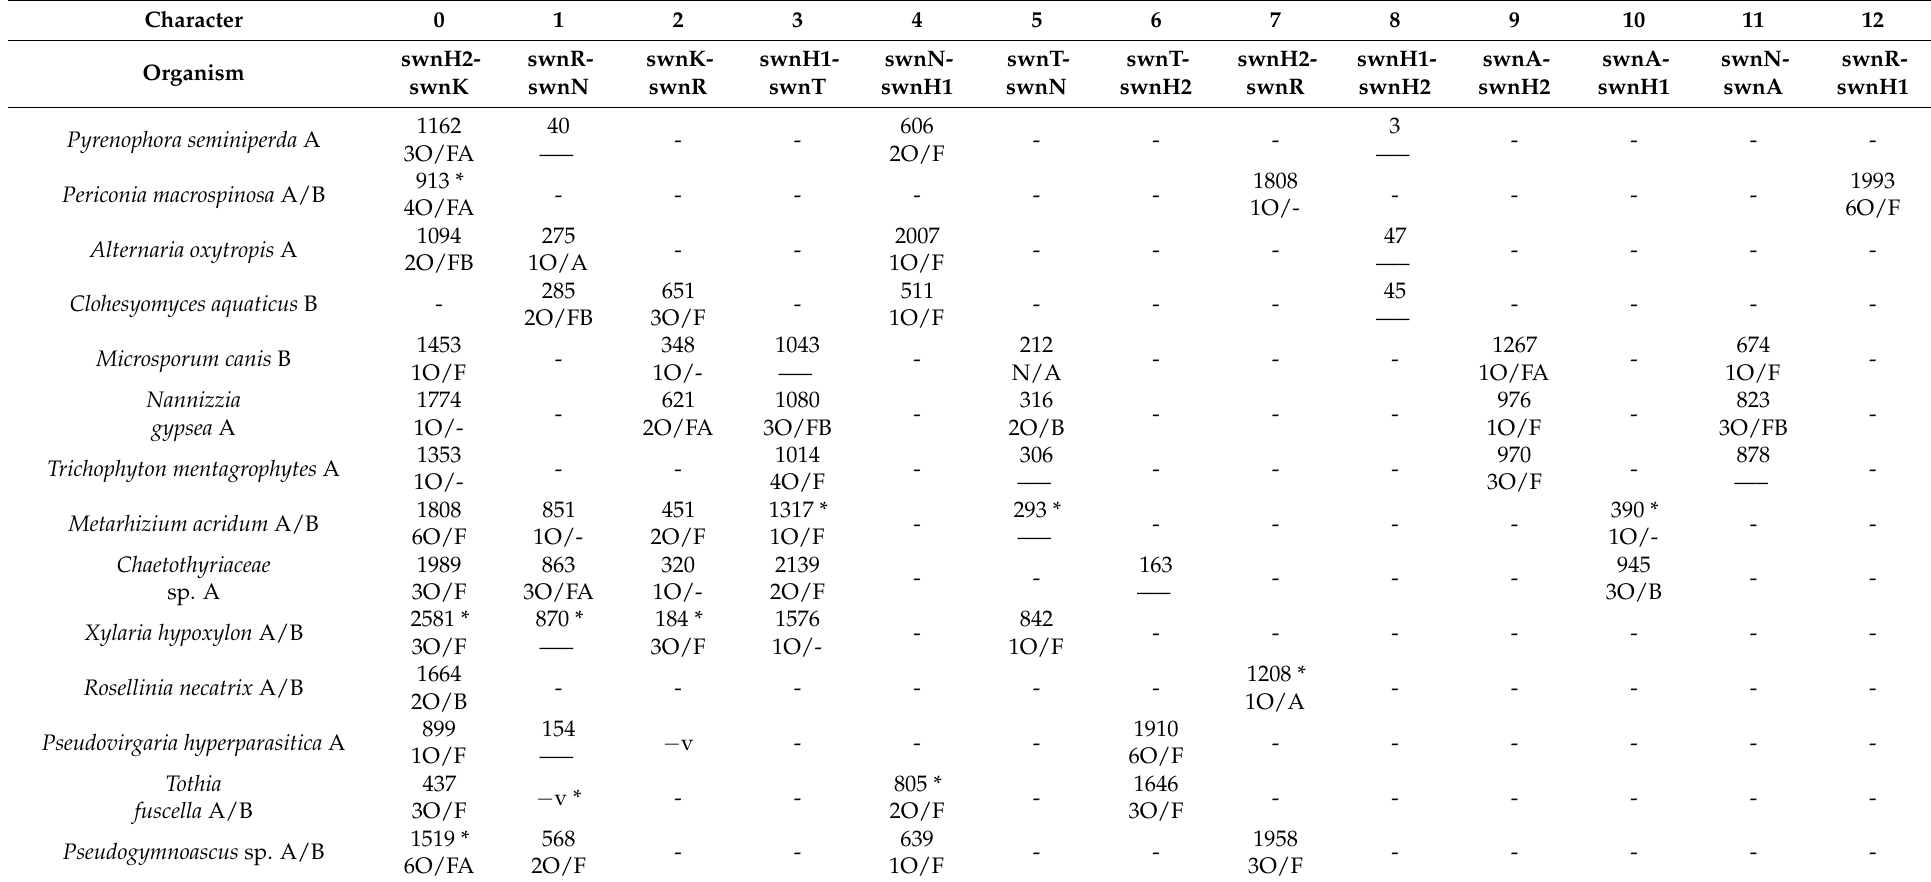
Table 2. Intergenic regions (IG) of swainsonine genes. These 13 combinations of IG are represented as characters 0–12. The letters A, B, and A/B placed next to each organism represent the type of combination. Type A are those from 0–12, type B is their inversion, and type A/B indicates the organism has mix of A and B types. Numbers represent IG length. (*) after IG size indicates that IG was inverted (type B). Codes under each IG length (with the letter O) represent open reading frames (ORF). The number before the “O” indicates the number of ORFs with significant matches, and the letters after the “O” represent match type, F = fungus, B = bacteria, and A = amoeba. Other codes: (-) = absence of character, (—–) = blast search did not record any matches, ( − v) = overlap, (N/A) = ORFS do not exist. (1O-) no significant matches due to low query cover QC and/or percent identity